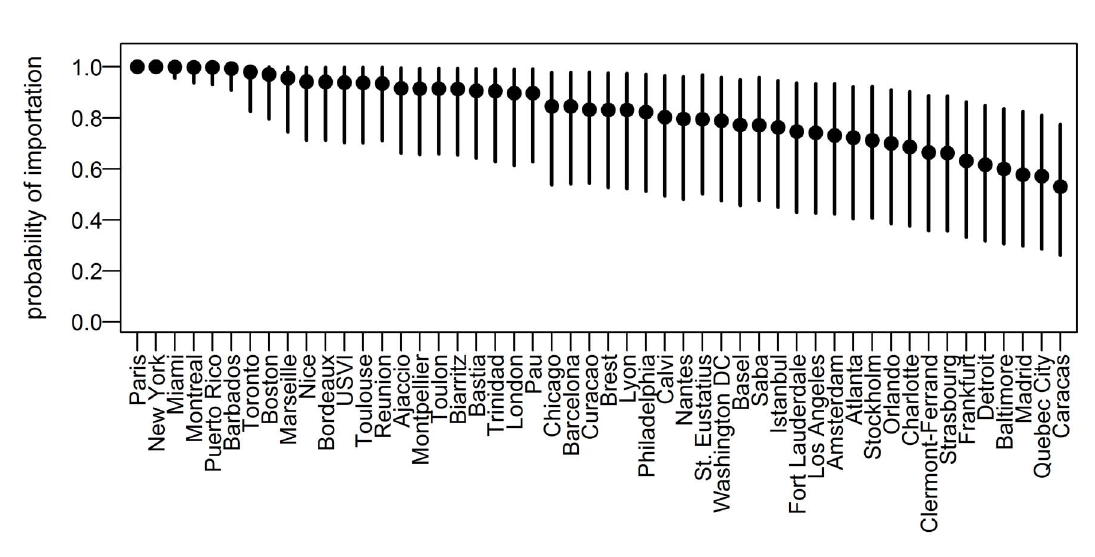
Figure 2. Probability of chikungunya virus importation for select locations, April 2014. Location-specific mean estimates (points) and 95% percentiles (lines) for the predicted probability of the arrival of at least one chikungunya infected traveler for the 50 locations most likely to have had imported cases in April. USVI: U.S. Virgin Islands.